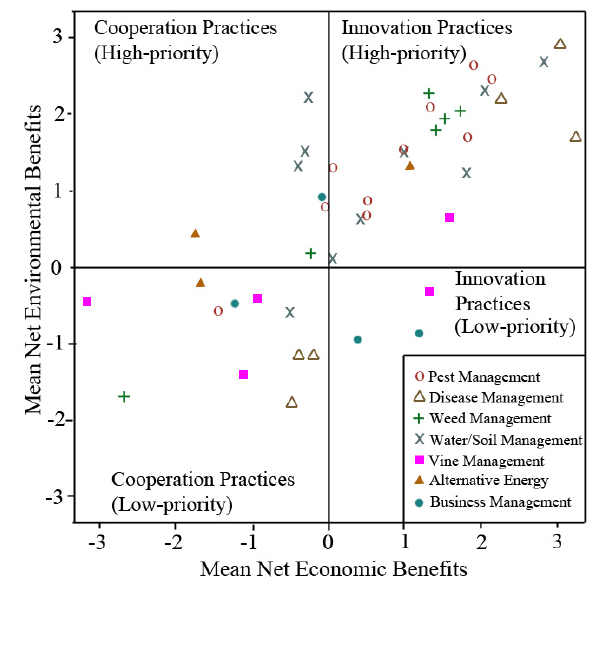
Fig. 2. Categorization of practices by net